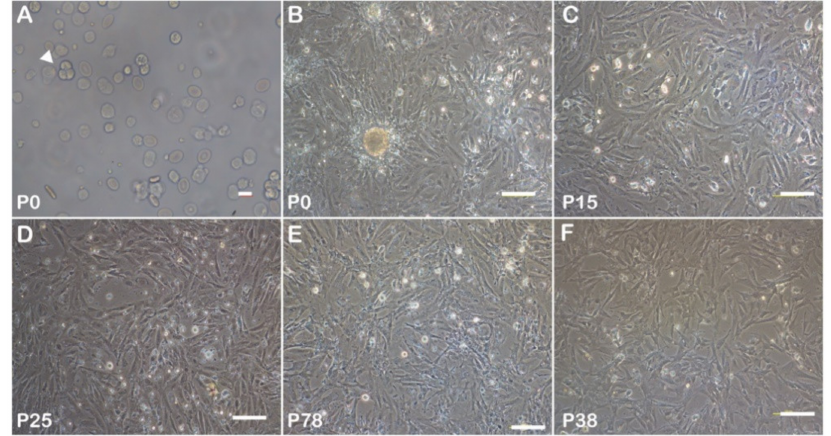
Figure 2. Coilia nasus gonad somatic (CnGSC) cells were cultured in vitro . ( A ) Cell mass was isolated from the gonads (arrow). ( B ) Primary culture of somatic cells for 5 days. ( C ) Morphology of somatic cells at passage 15 in sub-culture. ( D ) Sub-cultured CnGSC cells at passage 25. ( E ) Morphology of CnGSC cells at passage 78. ( F ) The monolayer of CnGSC cells (passage 38) recovered after three months. The cells retain their pre-cryopreservation morphology and proliferative ability. (Bars = 10 µ m in ( A ); 100 µ m in ( B – F )).